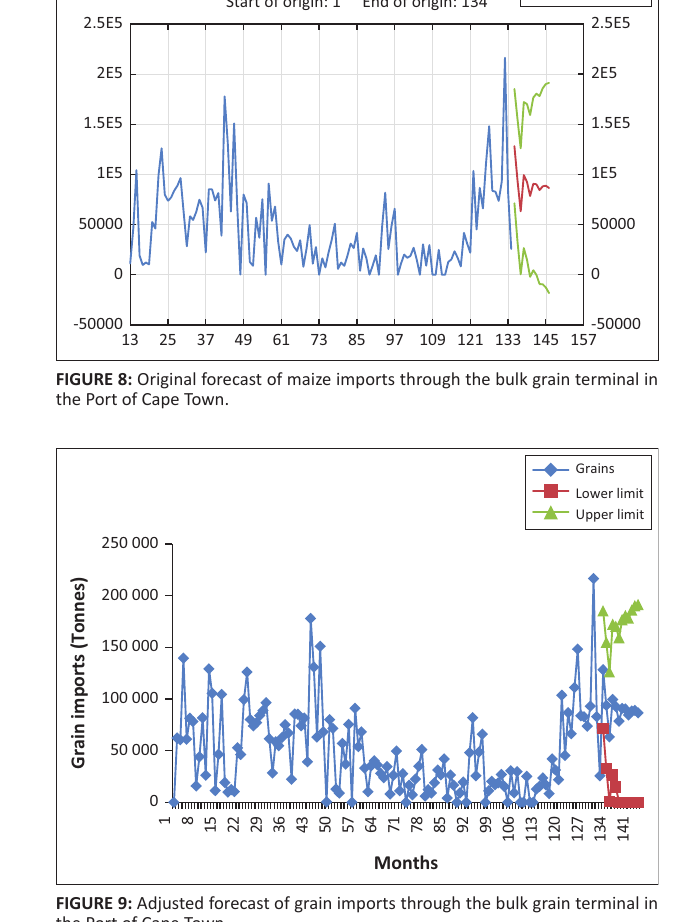
Forecasts; Model:(2,1,0) Seasonal lag: 12 Input: Grains